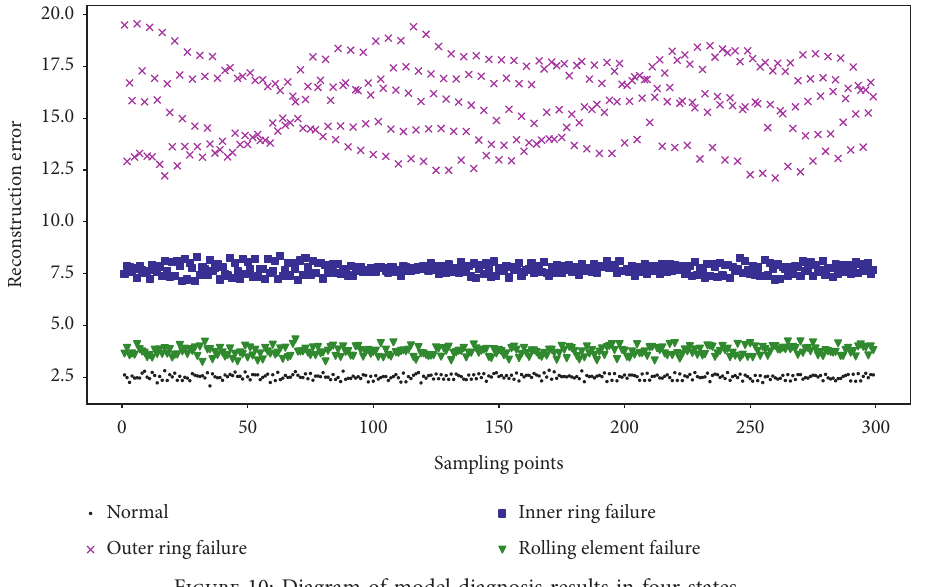
Figure 10: Diagram of model diagnosis results in four states.